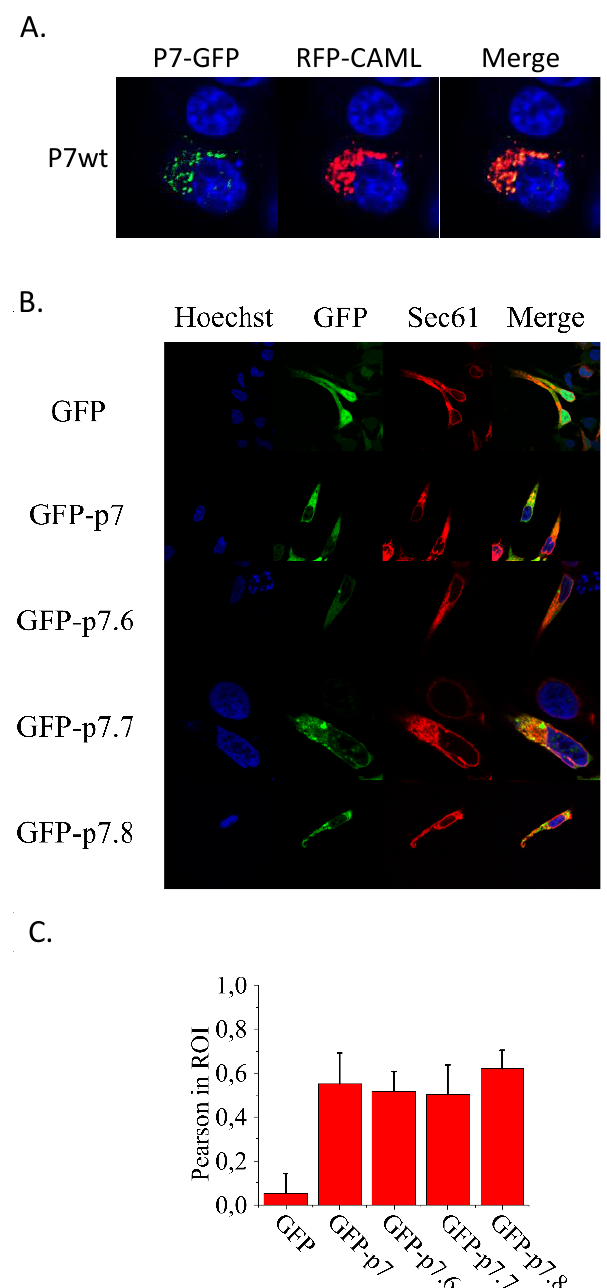
Figure 2. ( A ) Co-localization of p7 and CAMLG in transfected SK6 cells imaged at 1000×. p7-GFP and RFP-CAMLG constructs were co-transfected in SK6 cell monolayers. p7 mutant constructs fused to GFP (7.6-GFP, 7.7-GFP and 7.8-GFP) were co-transfected with RFP-CAMLG in SK6 cells. Preparations were mounted with ProLong Gold antifade reagent containing DAPI to stain the nuclei. In the merged panel, yellow color indicates co-localization of GFP and RFP. ( B ) Transfection Native and mutated forms of p7 in 293T cells imaged at 630× located in the endoplasmic reticulum. Distribution of p7 and its mutants 7.6, 7.7 and 7.8 by confocal microscopy. Micrographs illustrate individual cells co-expressing GFP constructs and the ER marker mCh-Sec61. The control GFP devoid of membrane anchors labelled the complete cell (top panels), whereas GFP-p7 constructs were excluded from the nucleus and co-localized with mCh-Sec61. ( C ) Co-localization of mCh-Sec6 and GFP in the samples as calculated with the ImageJ plugin Coloc 2 program (http://imagej.net/Coloc_2). Measurements were carried out in at least 6 cells as those displayed in the previous panel. Bars represent mean values ± SE.